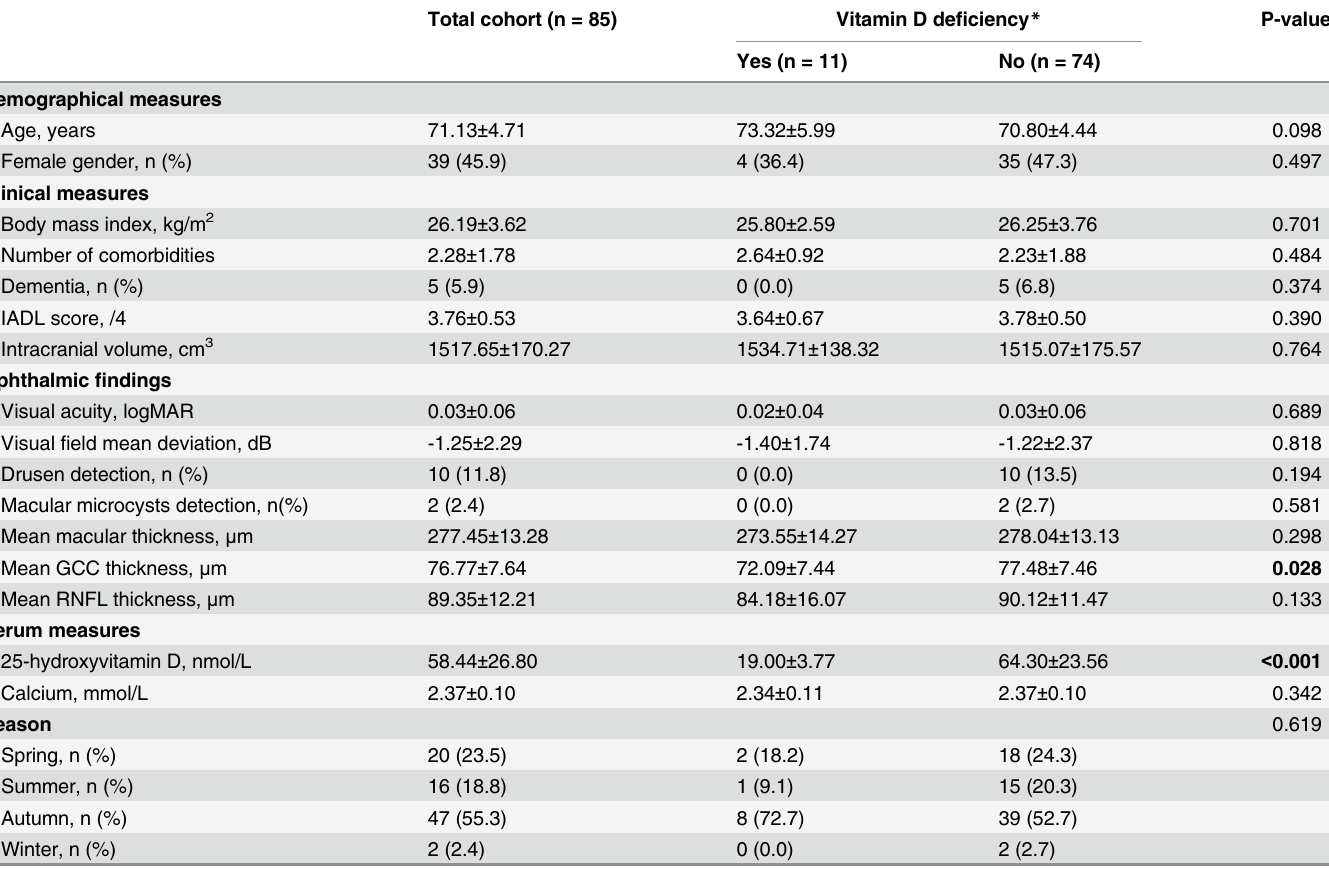
Table 1. Baseline characteristics of 85 participants by vitamin D